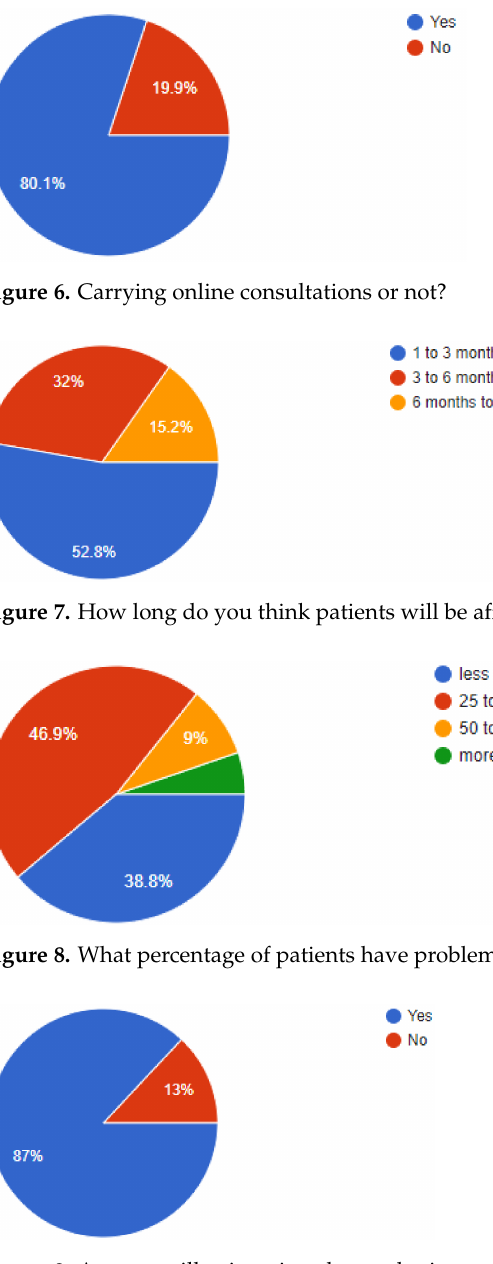
Figure 9. Are you still using virtual consultations, and will you continue to do so?